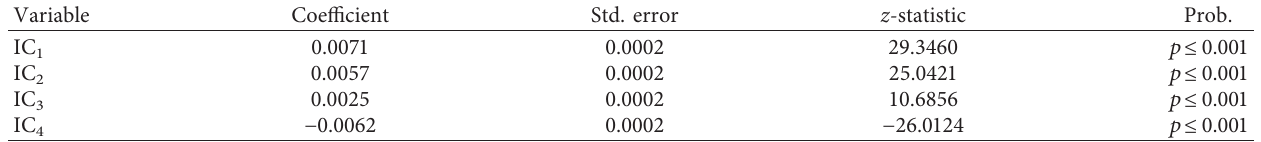
Figure 10: The time series of IC Table 5: The results estimated by the ICA-based ARMA-APARCH-M model for cluster 3.